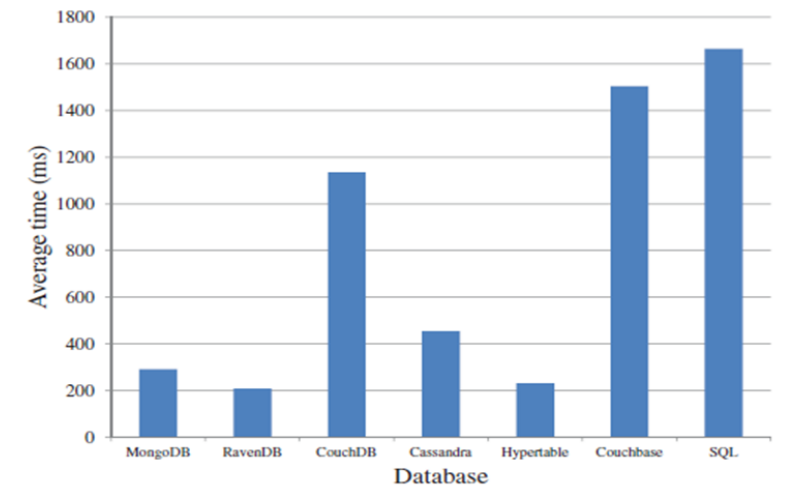
Fig. 2. Database Bucket Instantiating Time